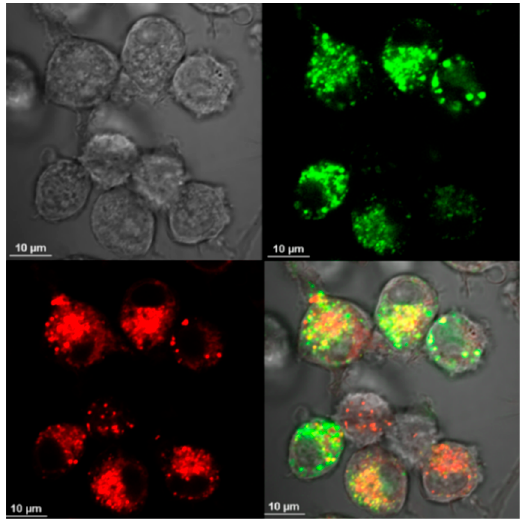
Figure 5. Localization of A β -HiLyte Fluor 488 (green) and lysosome marker LysoTracker Red DND-99 (red) in BV-2 cells. Confocal microscope, magnification 100 × .